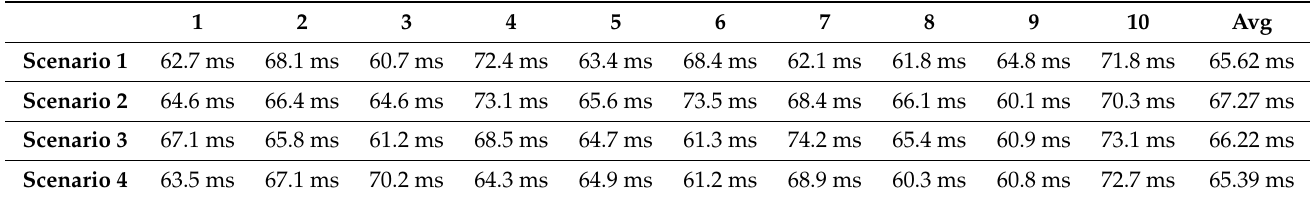
Table 5. Time to derive emotional results based on